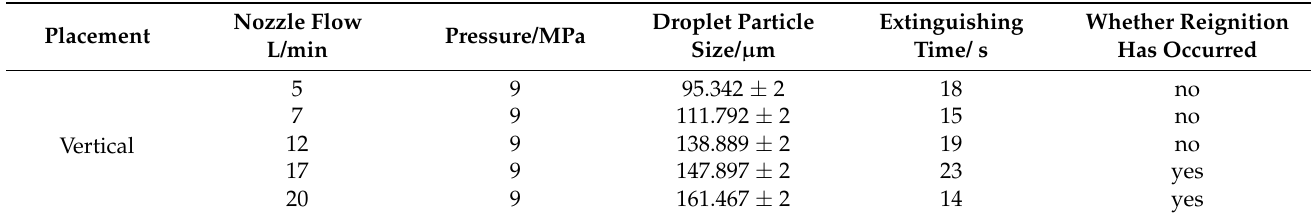
Figure 10. Temperature change diagram under different particle sizes: ( a ) is nozzle 1, ( b ) is nozzle 2, ( c ) is nozzle 3, ( d ) is nozzle 4, ( e ) is nozzle 5. Table 3. Fire extinguishing results from water mist under different